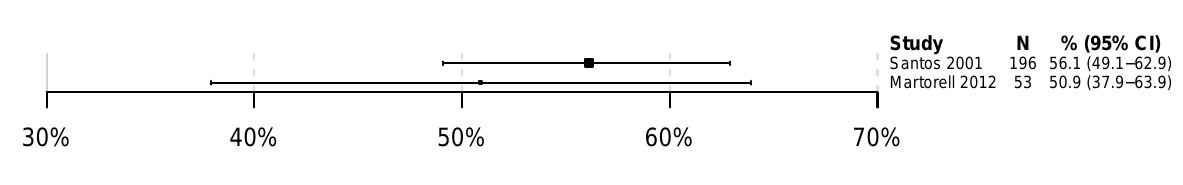
Figure 59: HPV 16 prevalence among women with invasive cervical cancer in Peru, by